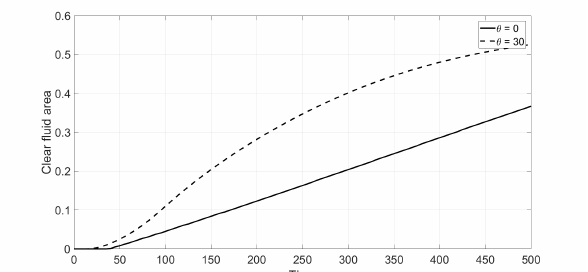
Figure 10. Reduced volumetric rate V ( t ) of the clear fluid zone c = 0 versus dimensionless time for the inclination angles α = 30 ◦ from the bottom upwards: Newtonian fluid.